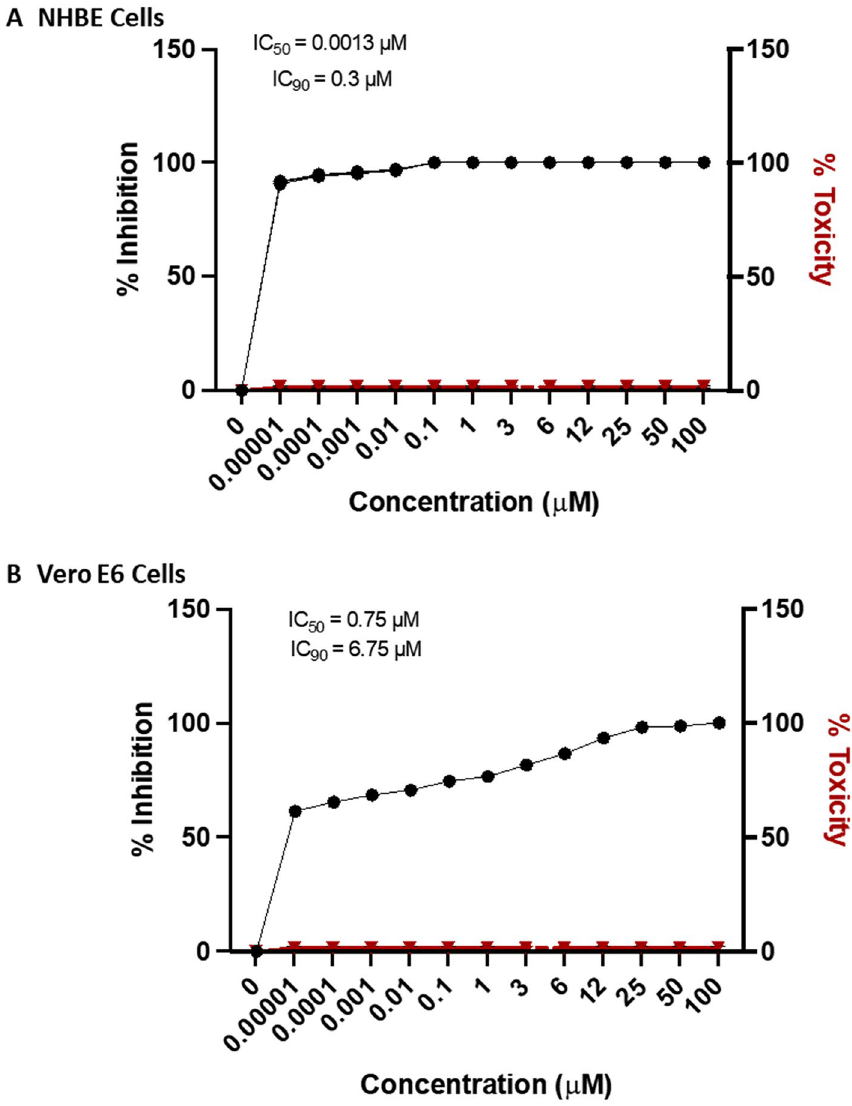
Figure 1. Probenecid potently inhibits SARS-CoV-2 replication in ( A ) NHBE cells and ( B ) Vero E6 cells. IC 50 and IC 90 values were calculated in NHBE cells and Vero E6 cells after treating with different probenecid concentrations. Cellular toxicity was calculated in NHBE cells and Vero E6 cells following treatment with different concentrations of probenecid and performing a cell viability assay that measured the percent toxicity based on the conversion of a redox dye (resazurin) into a fluorescent end product (resorufin) after 72 h.